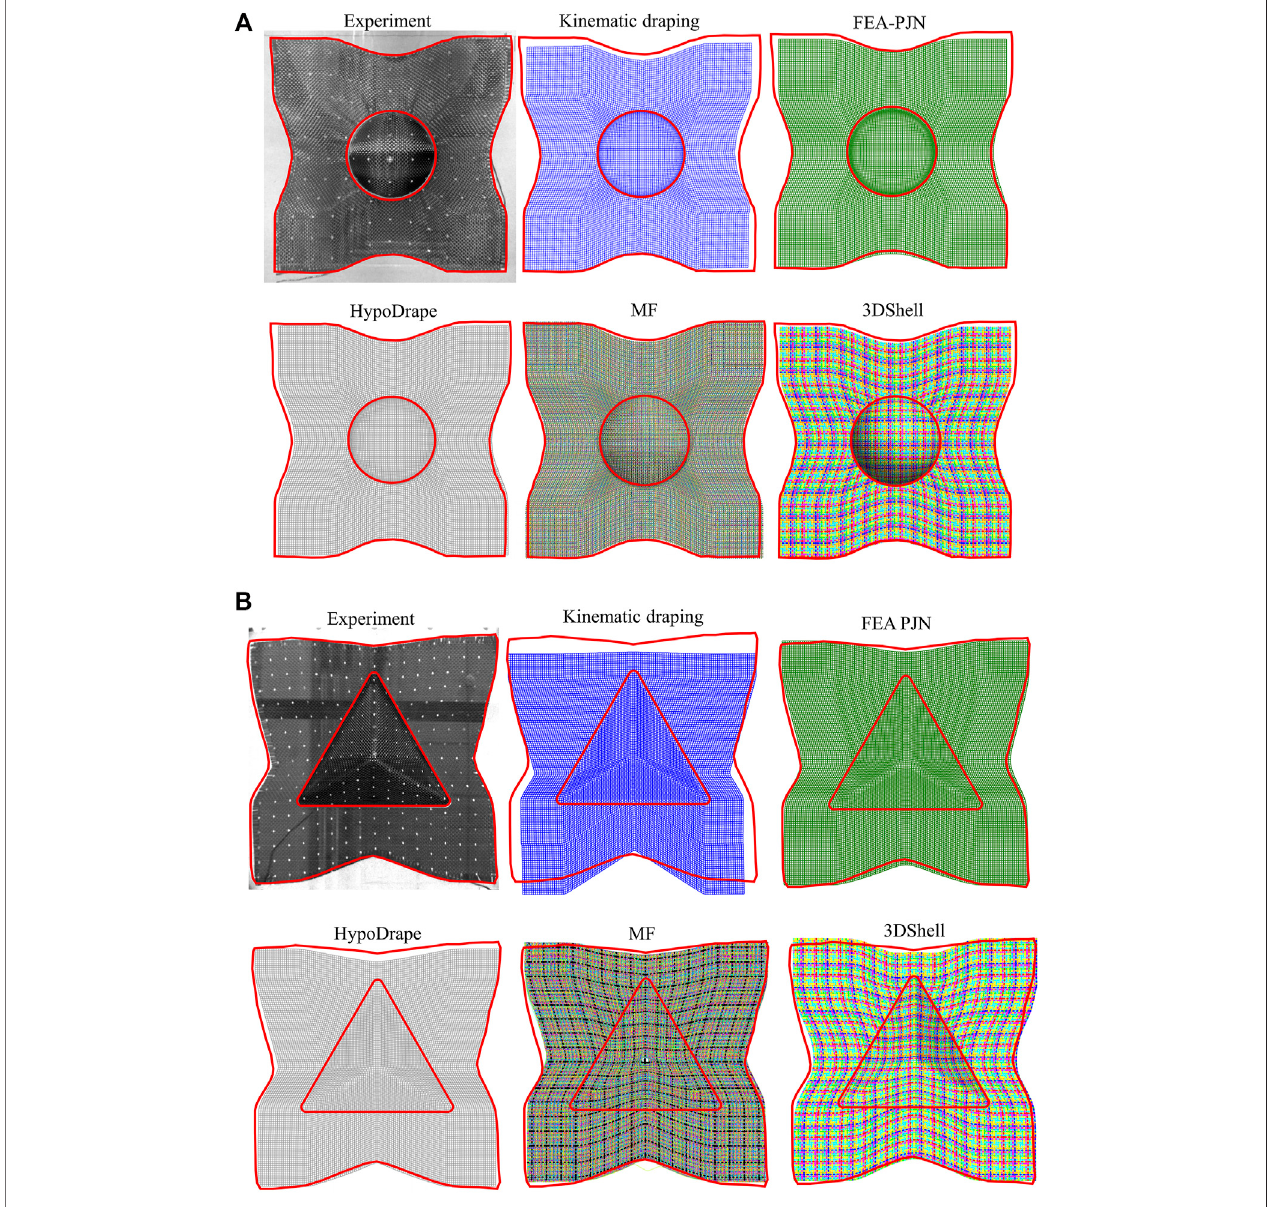
FIGURE 5 | Overviews of overall deformation of experimetnal and all modelling resutls in (A) hemispheric forming and (B) Tetrahedron forming. Pro fi les of the boundary of top blank holder window and deformed fabric are marked in red and are overlaid to all modelling for comparison purpose.